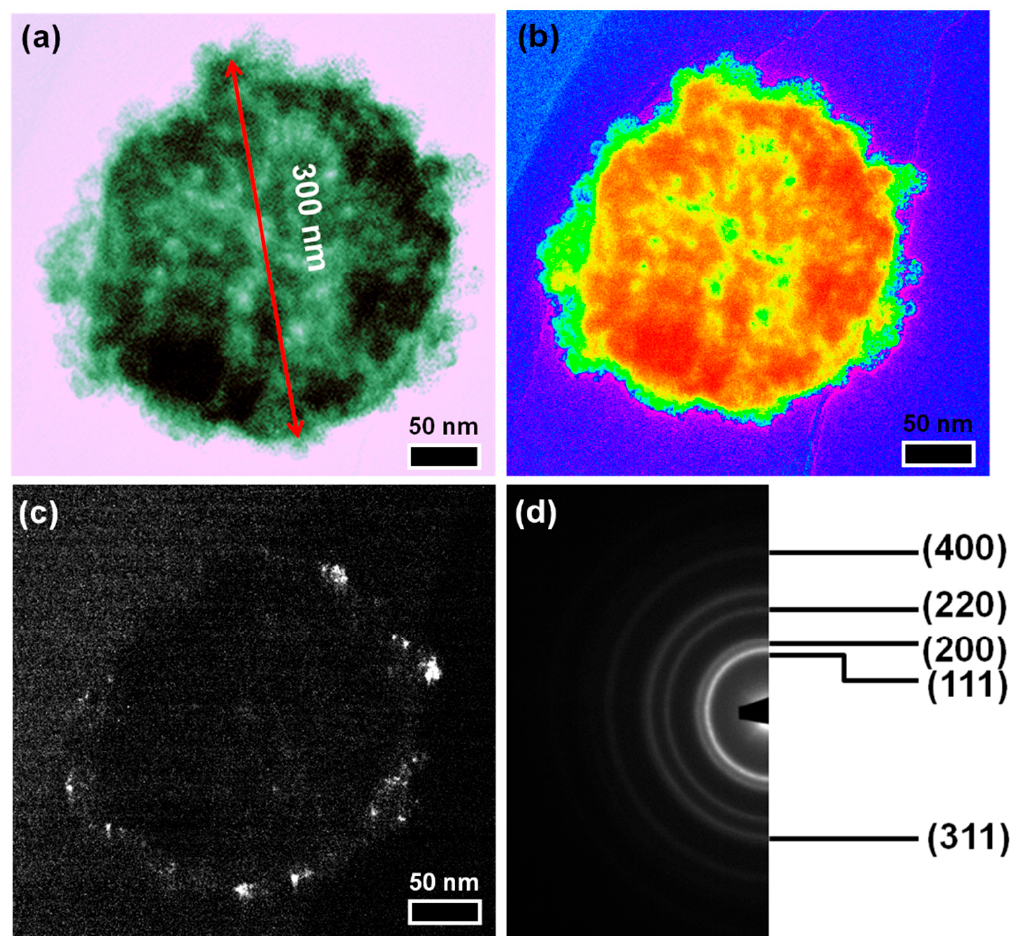
Figure 2. ( a ) Transmission electron microscope (TEM) image of a single Pt-based hollow nanostructure. ( b ) TEM image of a single Pt-based hollow nanostructure with enhance color contrast. ( c ) TEM-EELs mapping of Co element in the Pt-based hollow nanostructure. ( d ) The corresponding selected area electron diffraction (SAED) image of Pt-based hollow nanostructure.